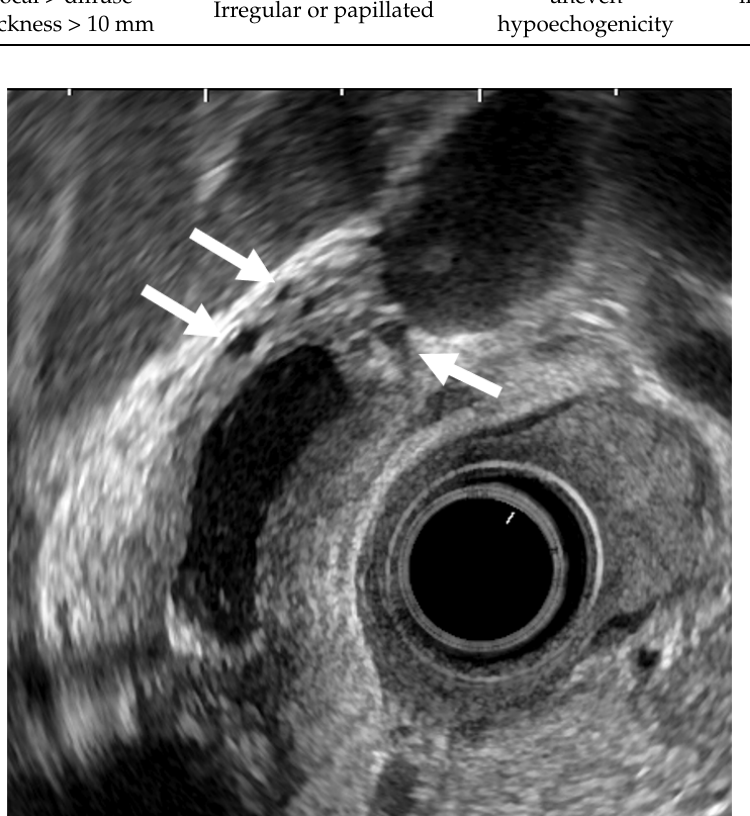
Figure 4. EUS image of ADM (diffuse type). The GB wall is diffusely thickened, and the layers of a thickened GB wall are preserved. Some anechoic areas (arrows) are visualized in the GB thickened wall. Xanthogranulomatous cholecystitis (XGC) is an uncommon disease involving